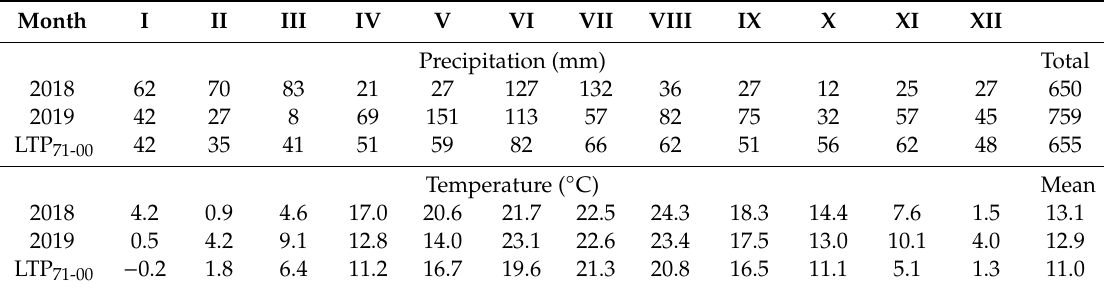
Table 1. Monthly climate data related to the two crop